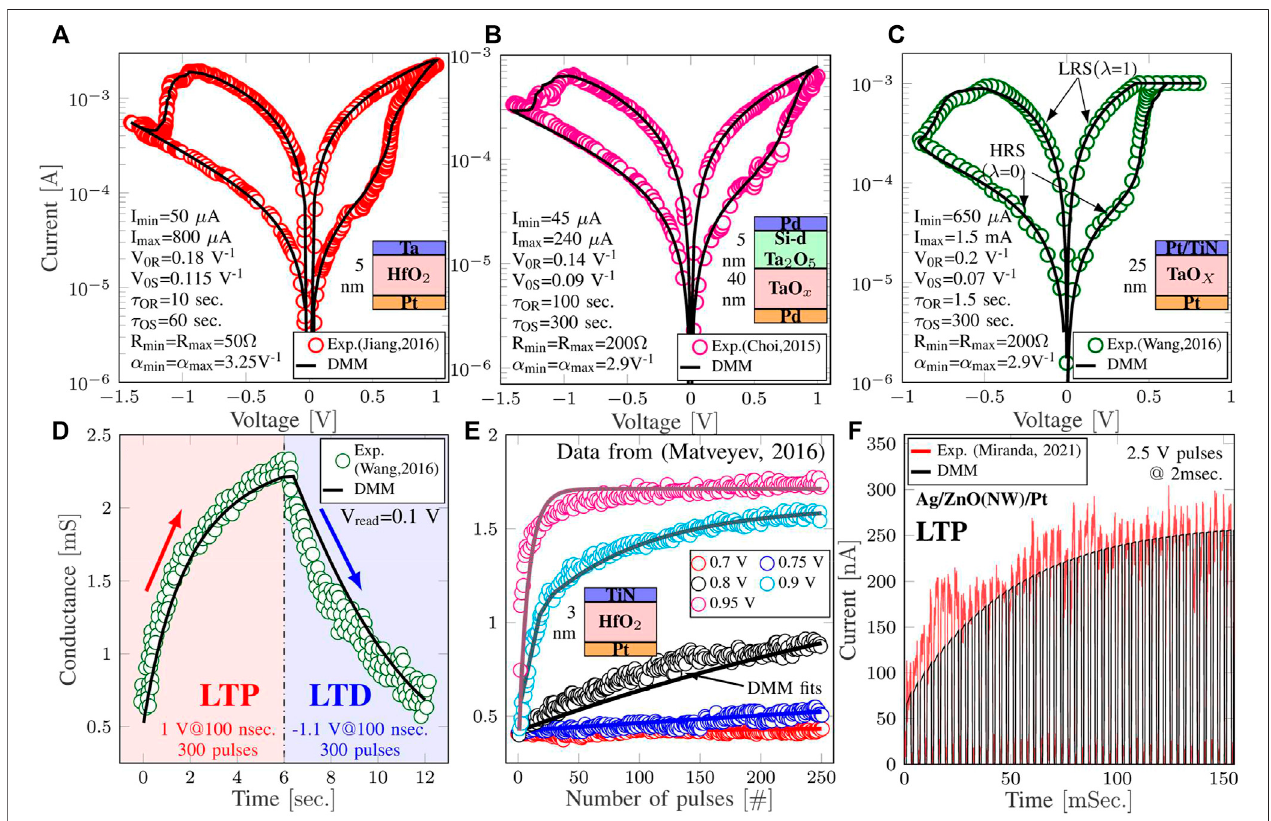
FIGURE4| Experimental I-V loopsofdifferentmemristorstructuresreportedintheliterature fi ttedwiththeDMMmodel: (A) Ta/HfO 2 /Pt[73], (B) Pd/Ta 2 O 5 /TaOX/Pd[74]and (C) TaO X [75].TheDMM fi ttingparametersareshownforeachcase.Asreference,theHRSandLRScurvesareindicatedin (C) .Notethatin (C) acurrentcomplianceof1 mAwas imposedtopreventpermanentdielectricbreakdown,whichcanbealsorepresentedbytheDMMandSPICE. (D) Pulse-enabledLTPandLTDdatafrom[73]wasalsousedtotest thesuitabilityoftheDMMtoreplicatethepotentiationanddepressionbehaviorofmemristorwithmultipleintermediatestates. (E) LTPdependenceonthepulsesamplitude [76] can also be captured with the DMM. (F) The versatility of the DMM also allow fi tting the current measured during the LTP of a Ag/ZnO/Pt nanowire memristive device